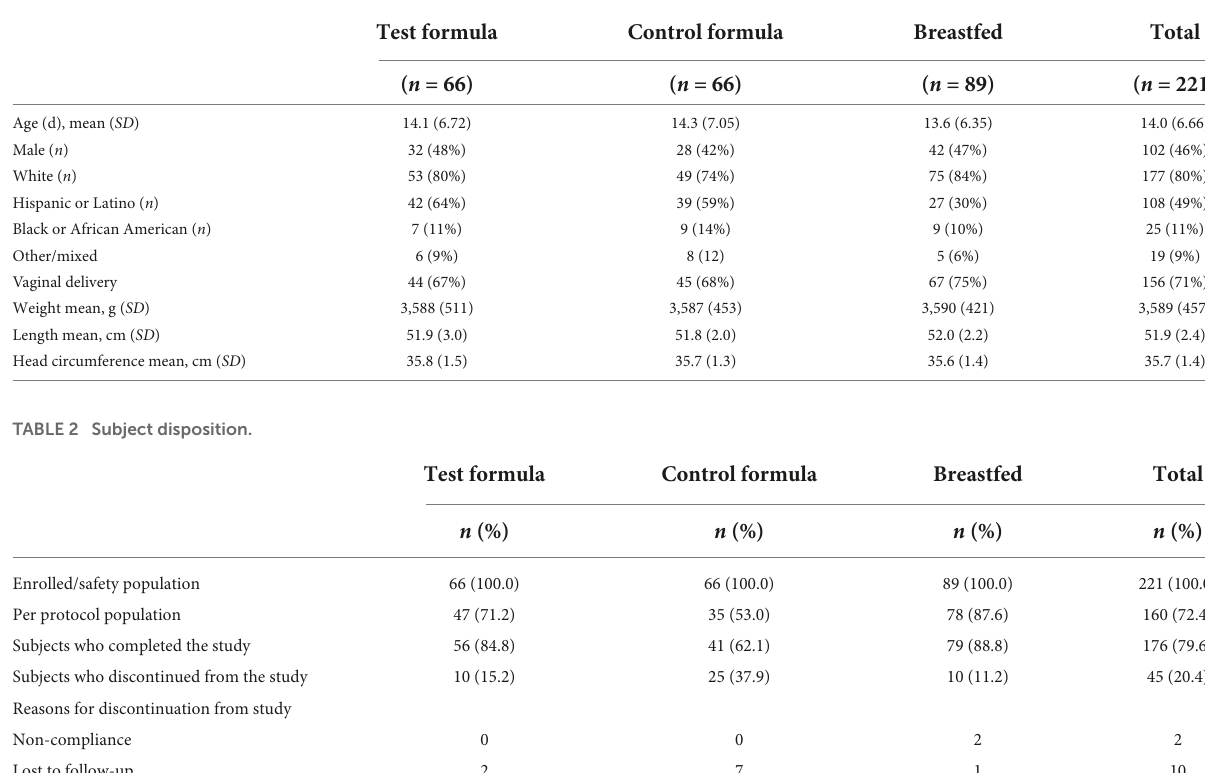
TABLE 1 Demographic and baseline characteristics (safety population).